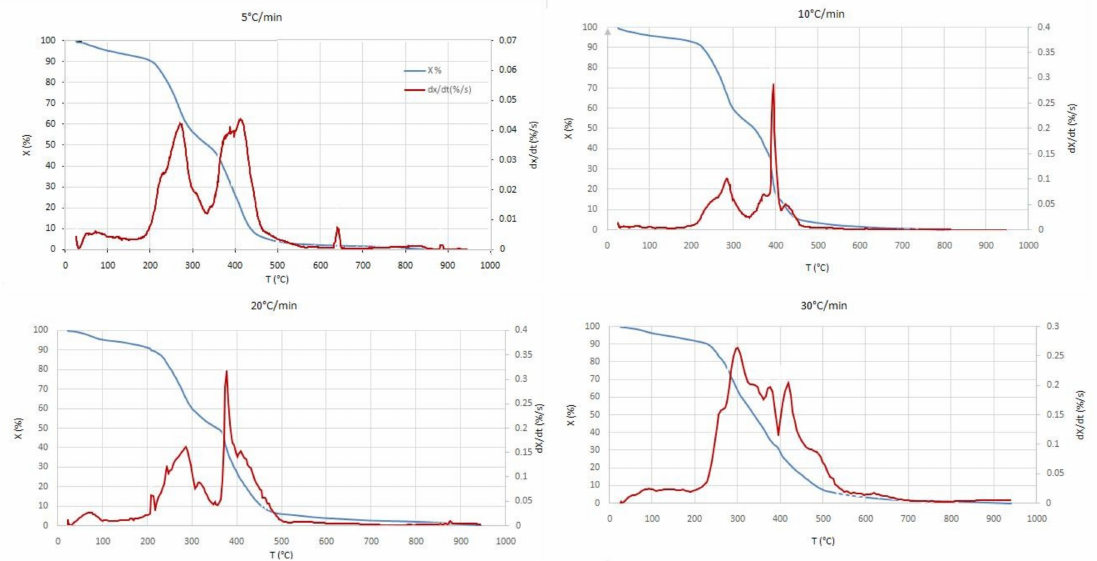
Figure 1. Profiles of tomato waste combustion for different heating